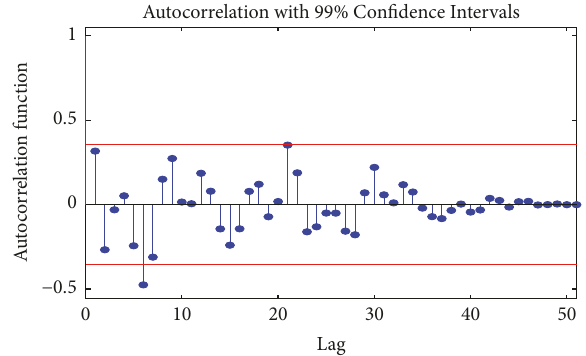
Figure 5: Correlation of residuals for the infected individuals Λ = 462 , 𝜇 = 0.003199 , 𝛽 = 0.69864 , 𝛽 = 0.04465 , 𝐾 = 200 , 𝛼 = ℎ 𝐵 0.0211 , 𝜖 = 0.01 , 𝛾 = 0.1106 , 𝜎 = 46.2086 , and 𝐾 =